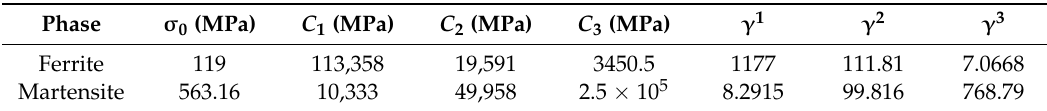
Table 4. Chaboche kinematic hardening parameters.